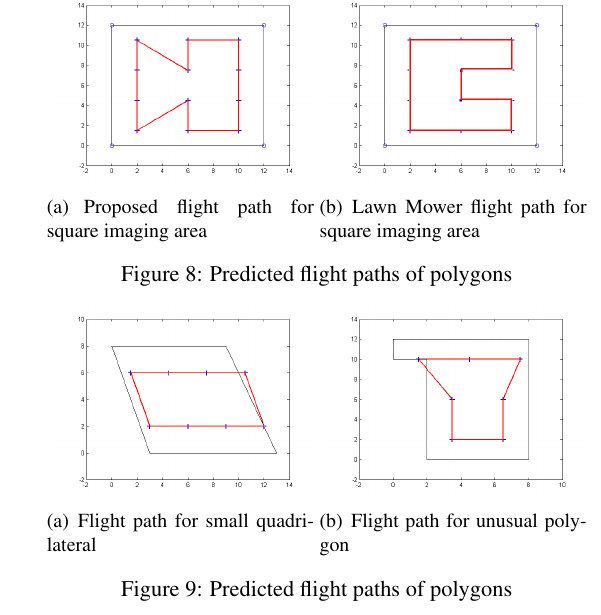
Figure 9: Predicted flight paths of